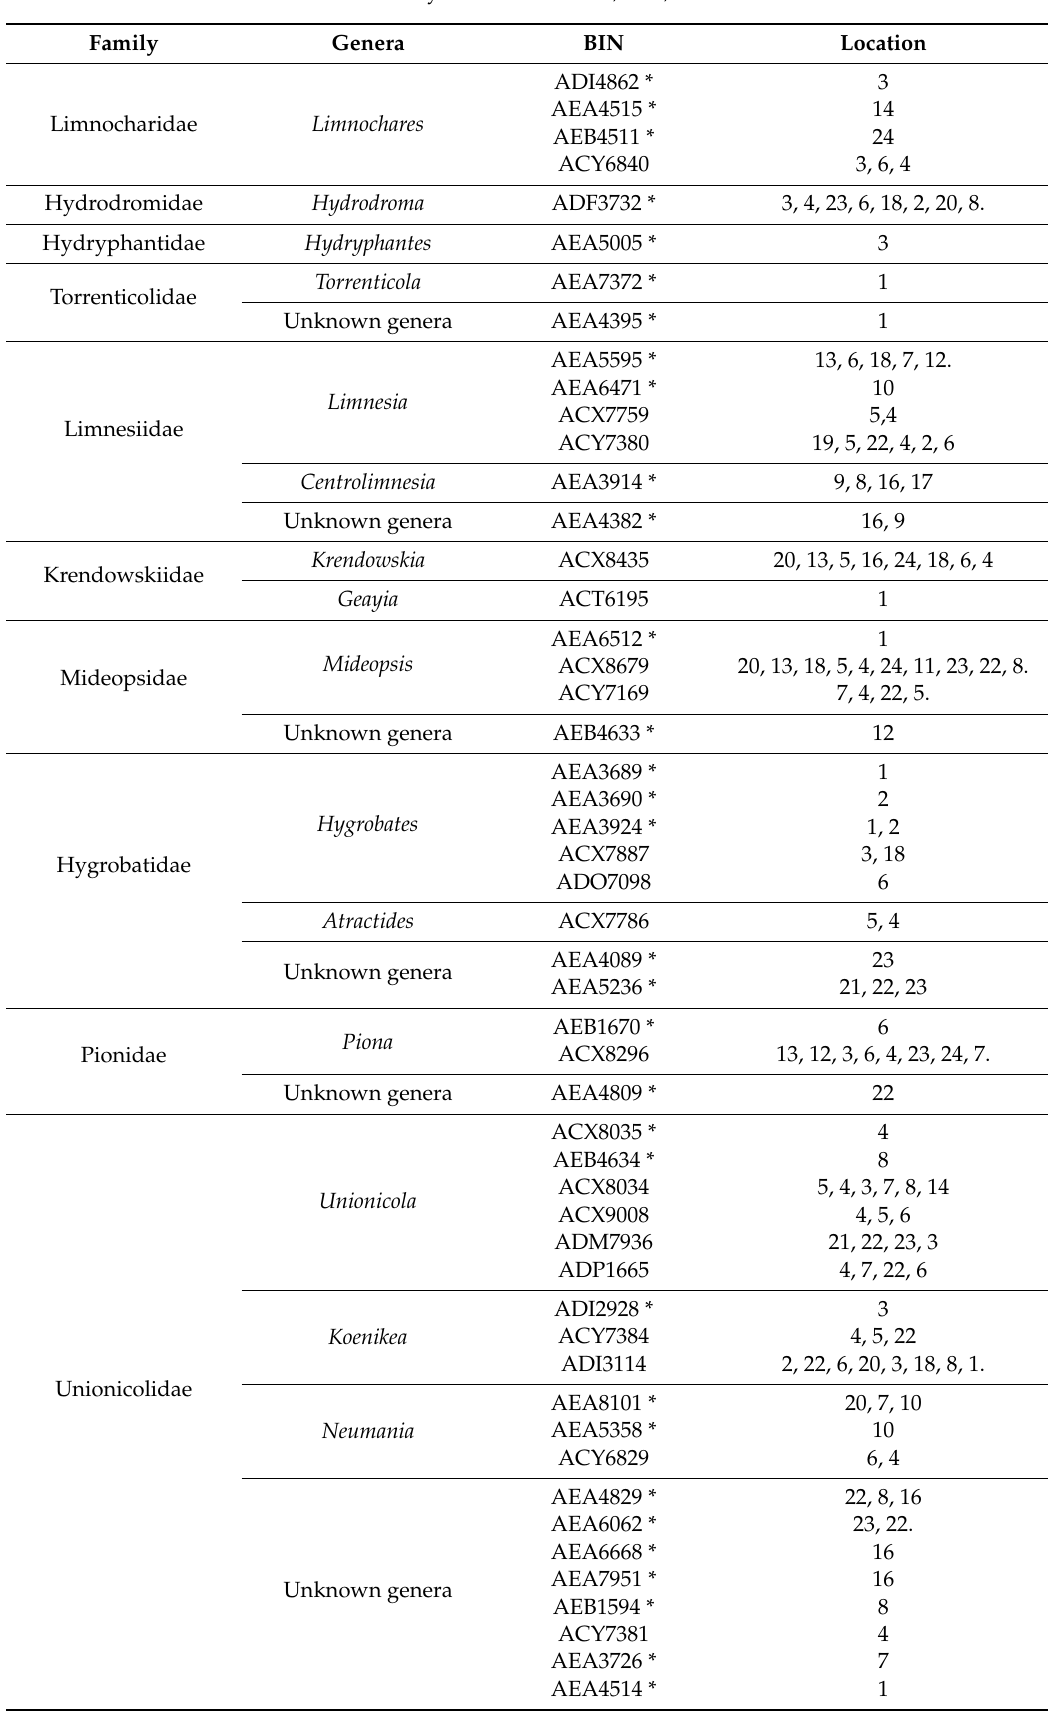
Table 2. Summary of taxa identified, BIN, and